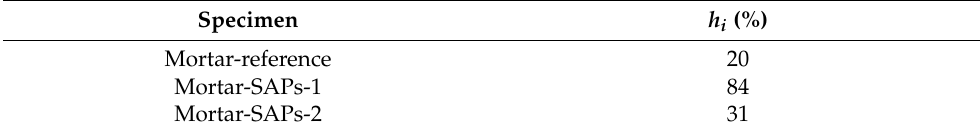
Table 5. Indexes h i for the mortar/SAPs specimens and control